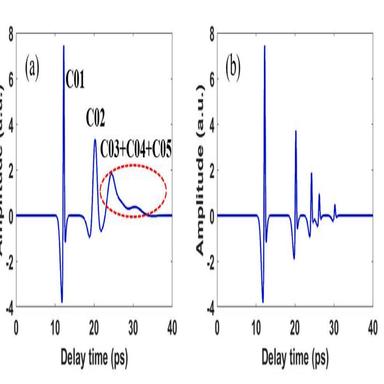
The synthetic THz TOFT signal composed of five wave packet components. (a) Overlapping dispersive THz TOFT signal without noise. (b) Theoretical THz TOFT signal with no dispersion corresponding to Fig. 5(a).